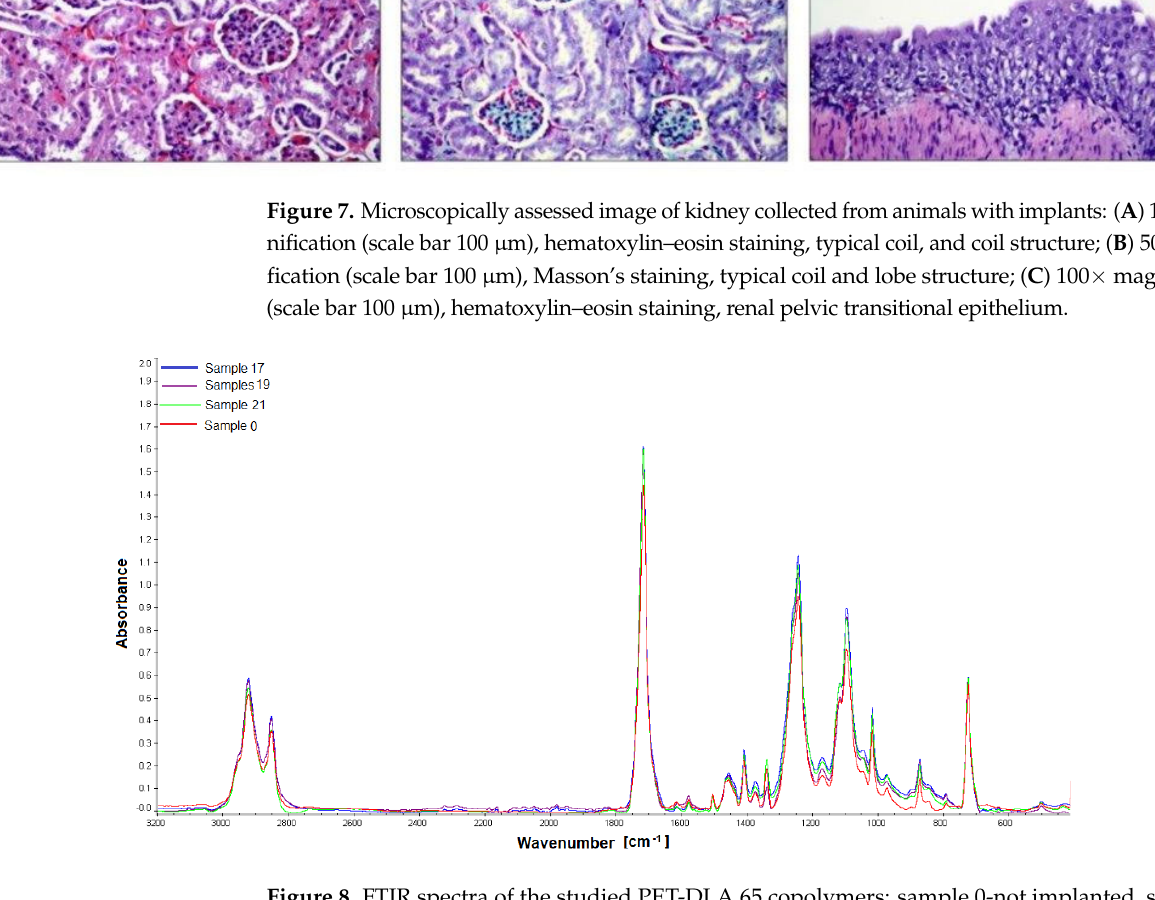
Table 2. The molecular weight characteristics and disparity index of PET/DLA copolymers before implantation and copolymers obtained after euthanasia of